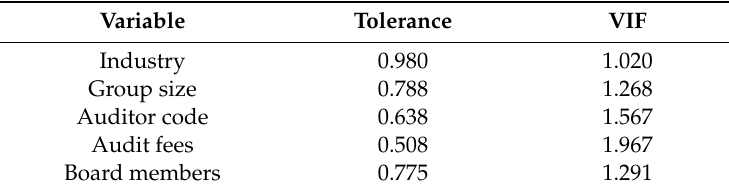
Table 5. Collinearity